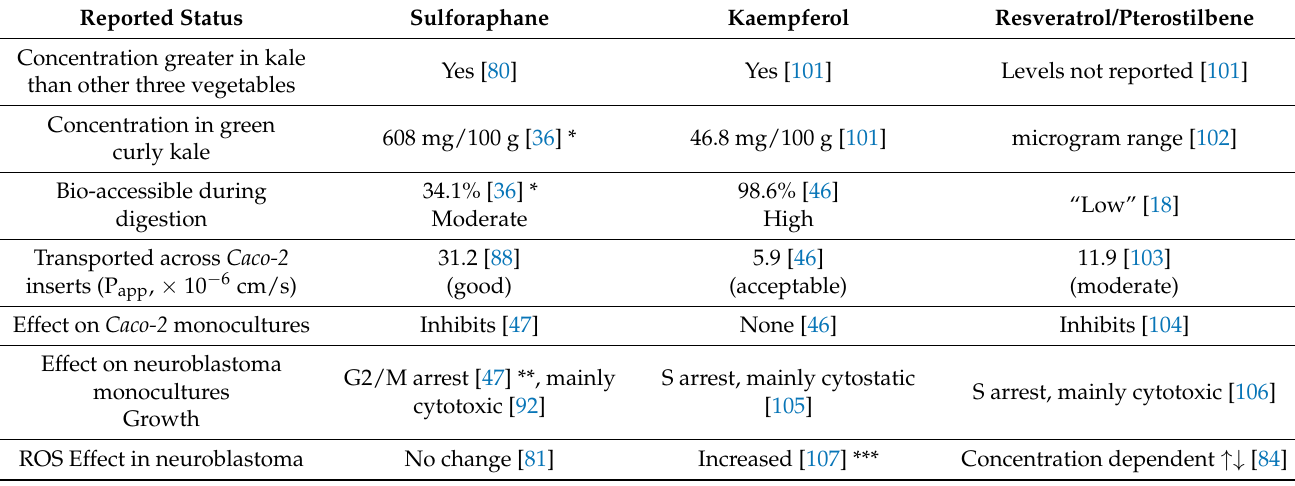
Table 3. Summary of main candidate molecules in comparison to published